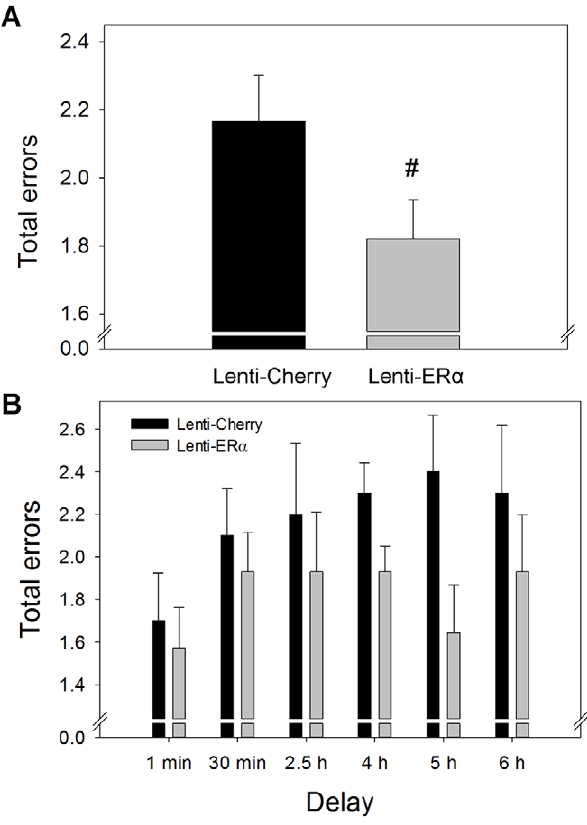
Figure 3. Effects of lenti-viral delivery to the hippocampus of the gene encoding ER a (Lenti-ER a ) or a control virus (Lenti- Cherry) to aging ovariectomized rats on number of total errors in a spatial memory radial-maze task when various delays were imposed between the 4 th and 5 th arm choices. (A) Mean number of total errors in the first eight arm choices ( + SEM) averaged across delays. # P=.077 vs. Lenti-Cherry. (B) Mean number of total errors of first eight arm choices ( + SEM) at each